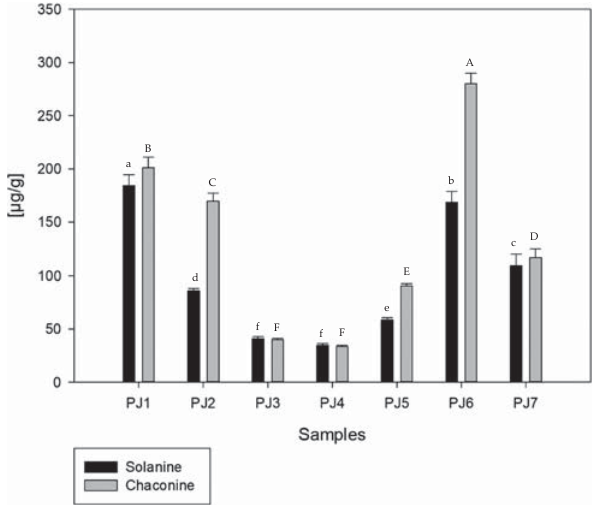
Figure 2: Results of LC – MS analysis of GAs. PJ1: VR 808, PJ2: Saturna, PJ3: Toscana, PJ4: Ditta, PJ5: Lord, PJ6: Denar, and PJ7: Lady Claire. Mean values with di ff erent letters are signi fi cantly di ff erent at α =